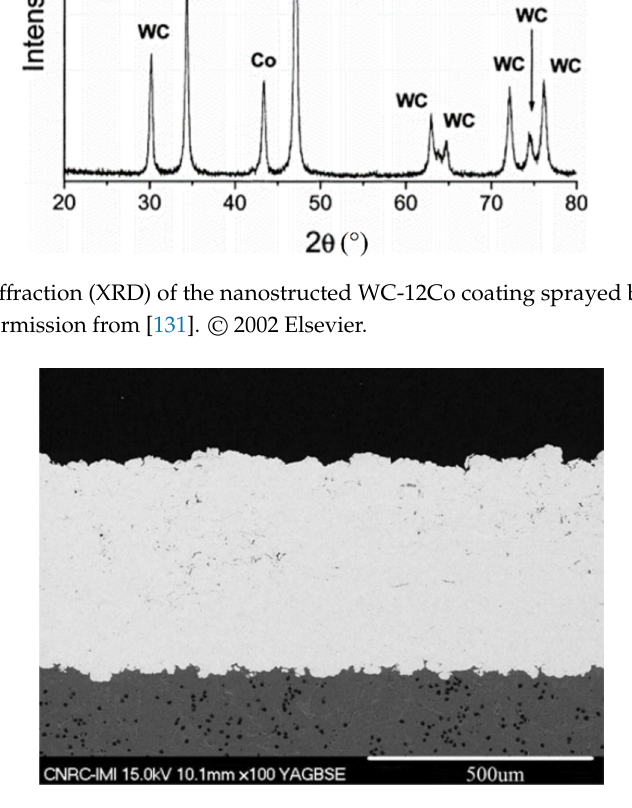
Figure 9. Scanning electron microscope (SEM) micrograph showing cross section of cold sprayed stainless-steel coating [132]. Reprinted with permission from [132]. © 2018 Springer Nature.